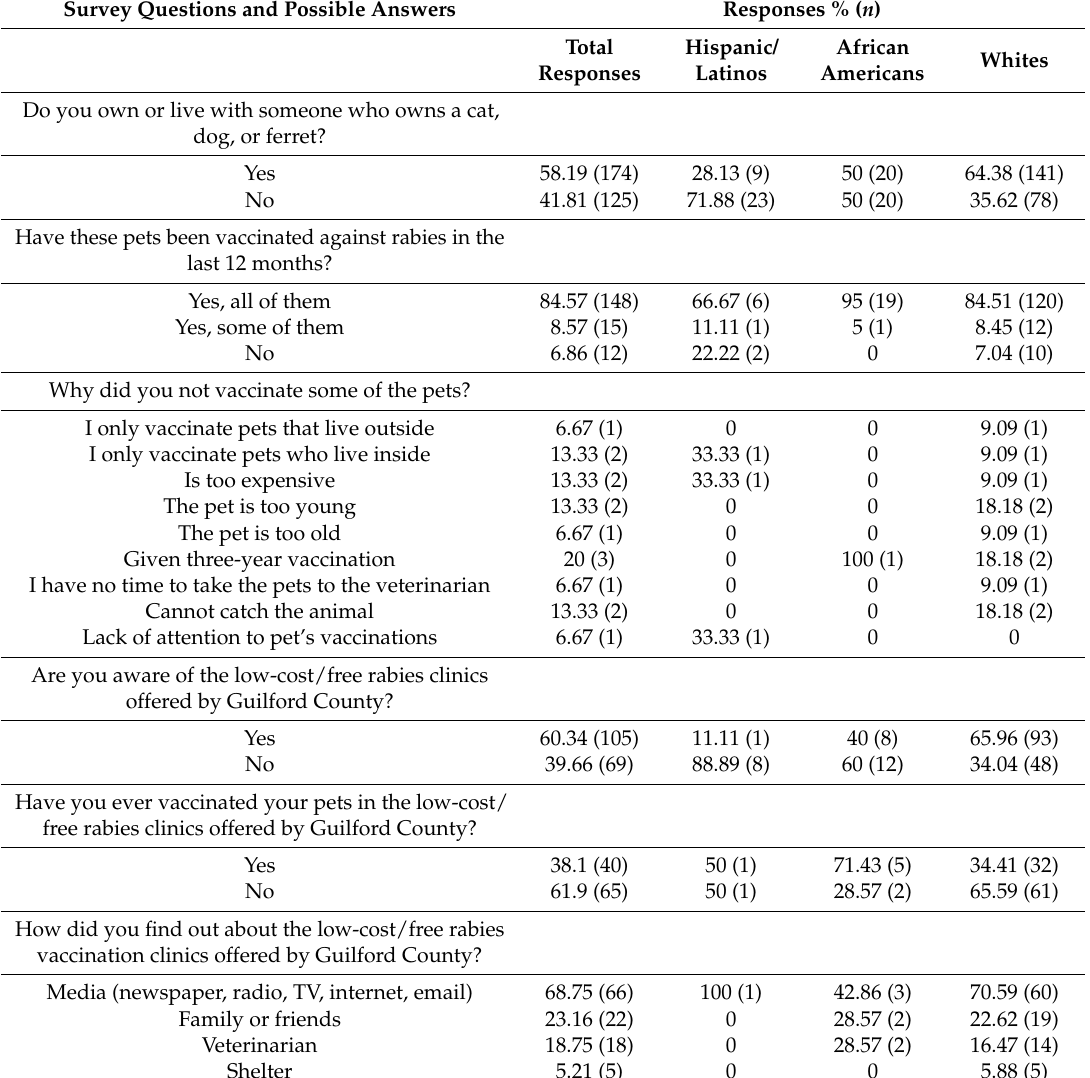
Table 1. Frequency of answers regarding pet vaccination status and awareness and use or rabies vaccination clinics in Greensboro, NC,